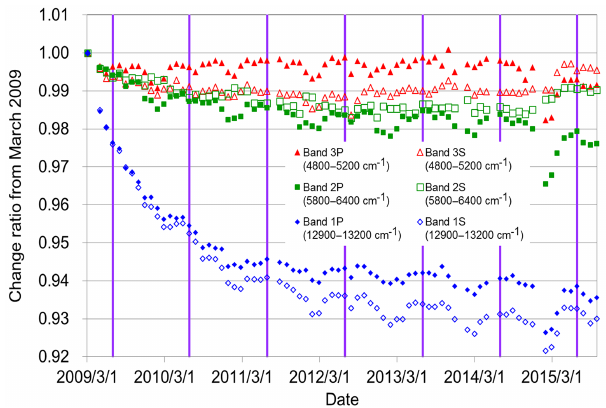
Figure 5. Solar irradiance monthly calibration data from the back side of the onboard Spectralon diffuser, which indicates the change from the first measurement in space after correction for the distance between the satellite and the sun and the angle of incidence of the solar beam upon the diffuser. The vertical lines represent the time of vicarious